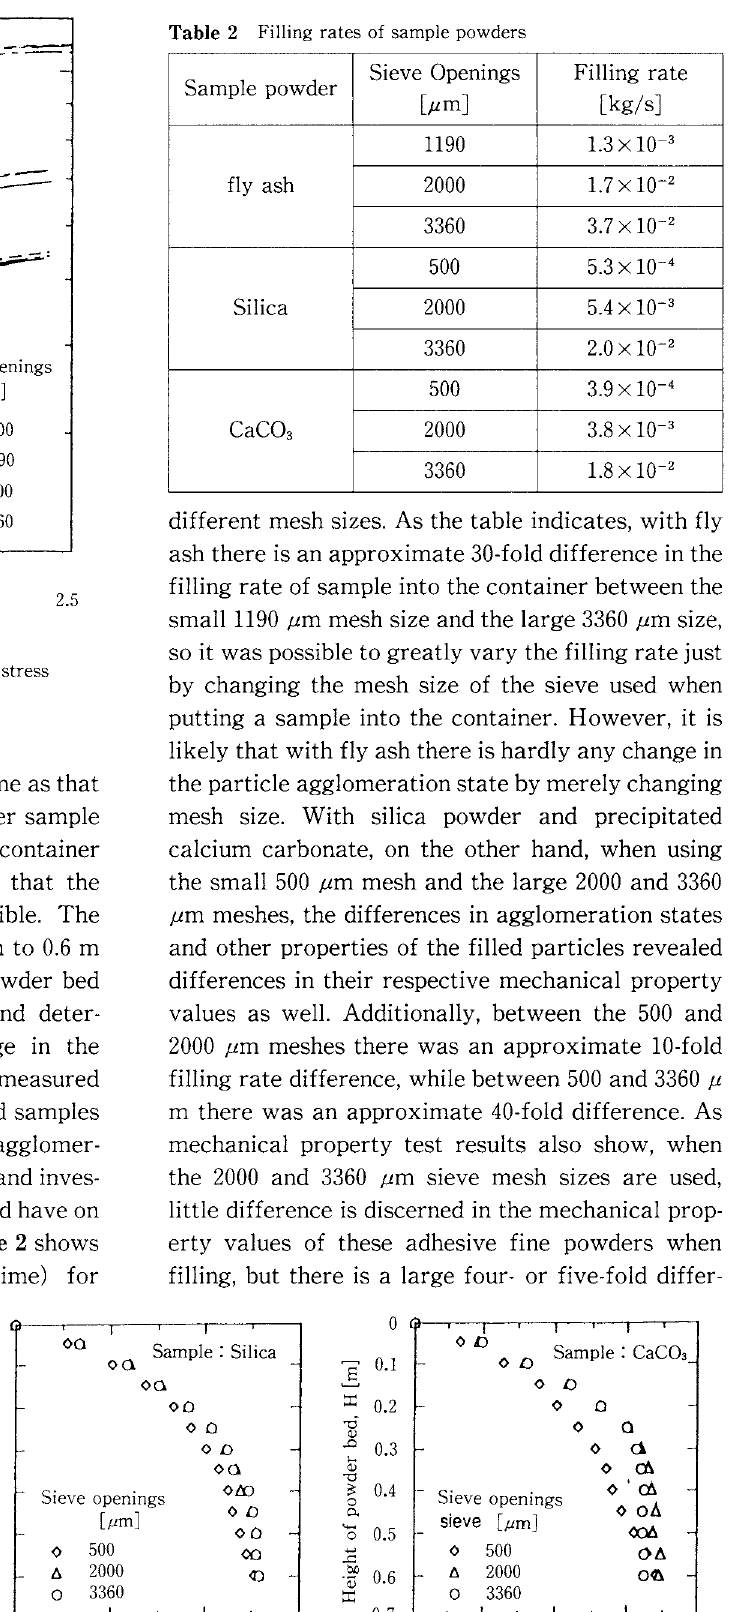
Table 2 Filling rates of sample powders Sample